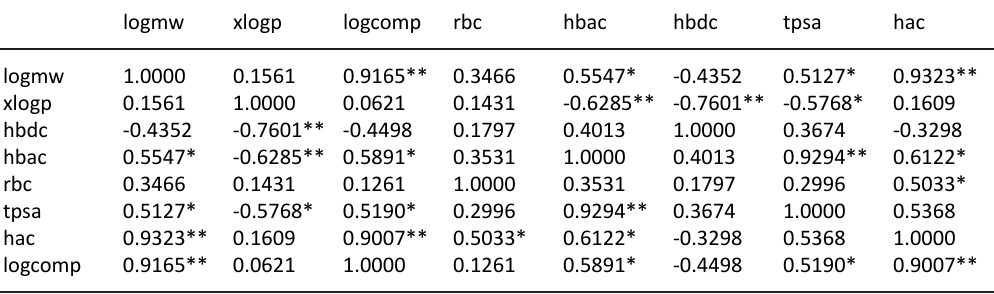
Table 4. Correlational analysis on the molecular descriptors of